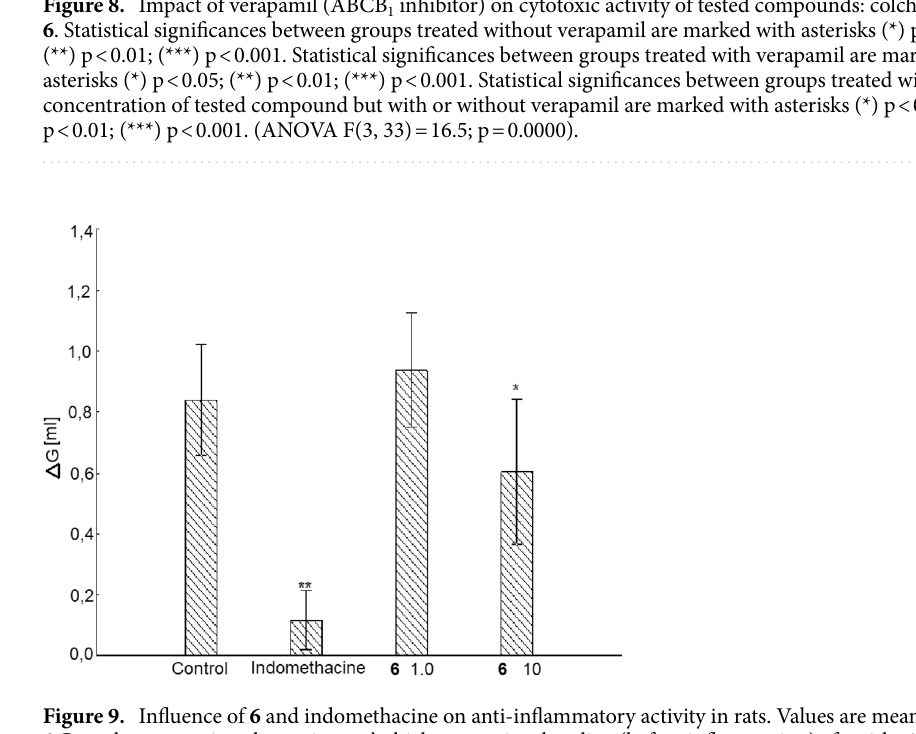
Figure 9. Influence of 6 and indomethacine on anti-inflammatory activity in rats. Values are mean ± SEM, ΔG—value expressing change in paw’s thickness against baseline (before inflammation) after 3 h, 6 ( 6–1.0) a dose of 1.0 mg/kg, 6 ( 6–10) a dose of 10.0 mg/kg, **, *—significant difference vs Control group; p < 0.05 or p < 0.1,